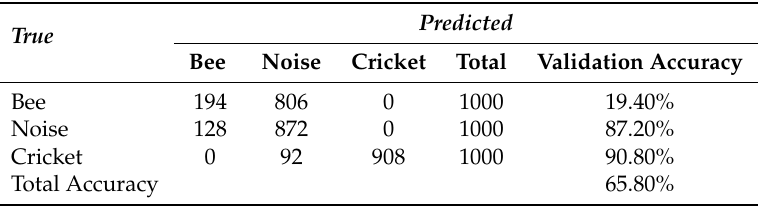
Table A15. Confusion matrix for KNN ( n = 5) on BUZZ2 validation dataset.